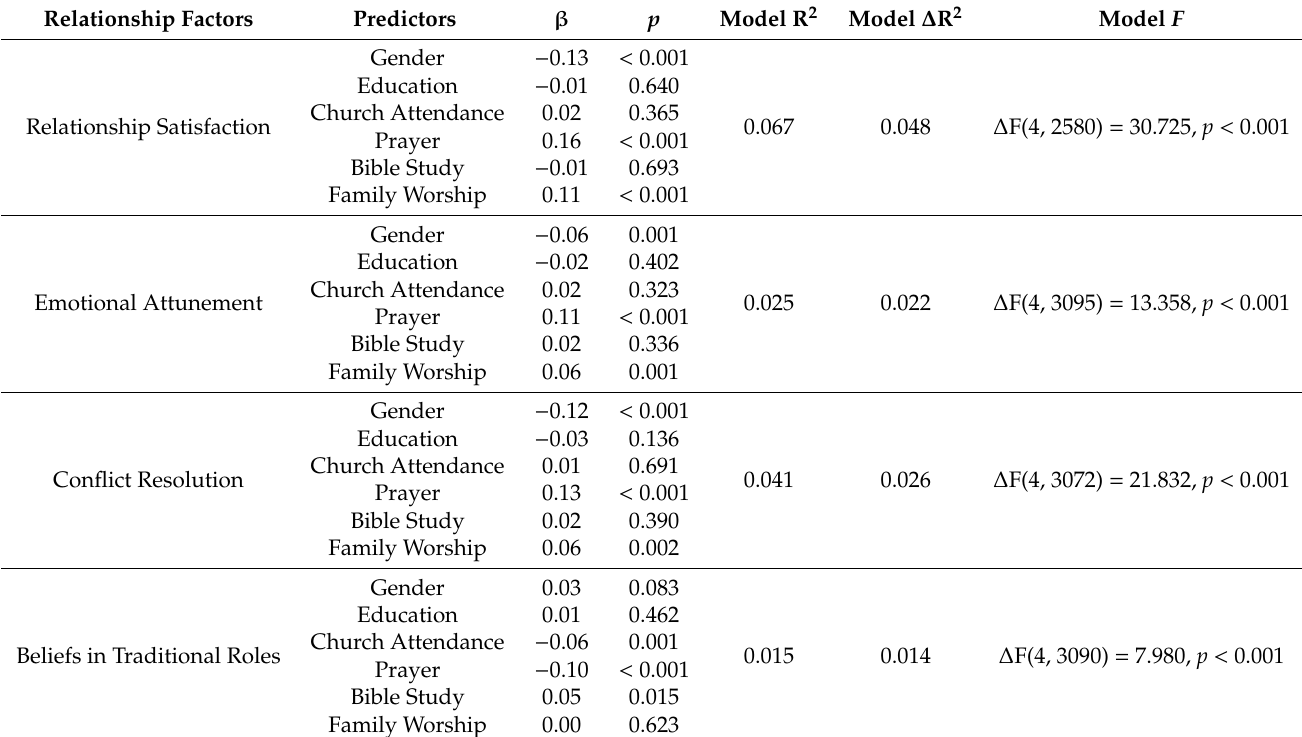
Table 1. Final hierarchical multiple regression model of married adult’s religious practices accounting for variance in relationship